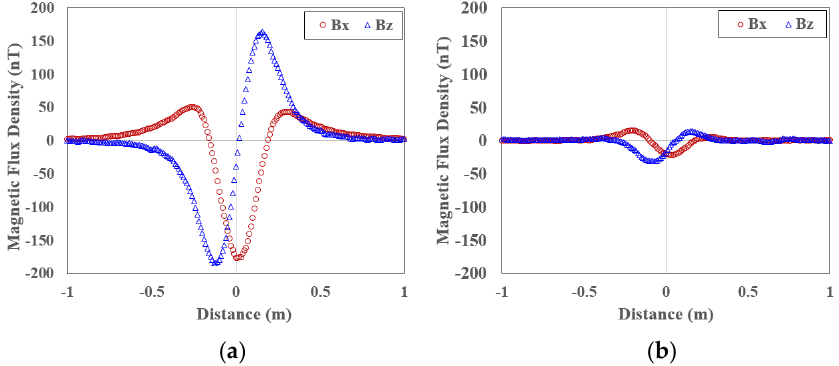
Figure 18. Deperming experiment results of SS400 depending on deperming protocols: ( a ) conventional protocol and ( b ) proposed protocol.